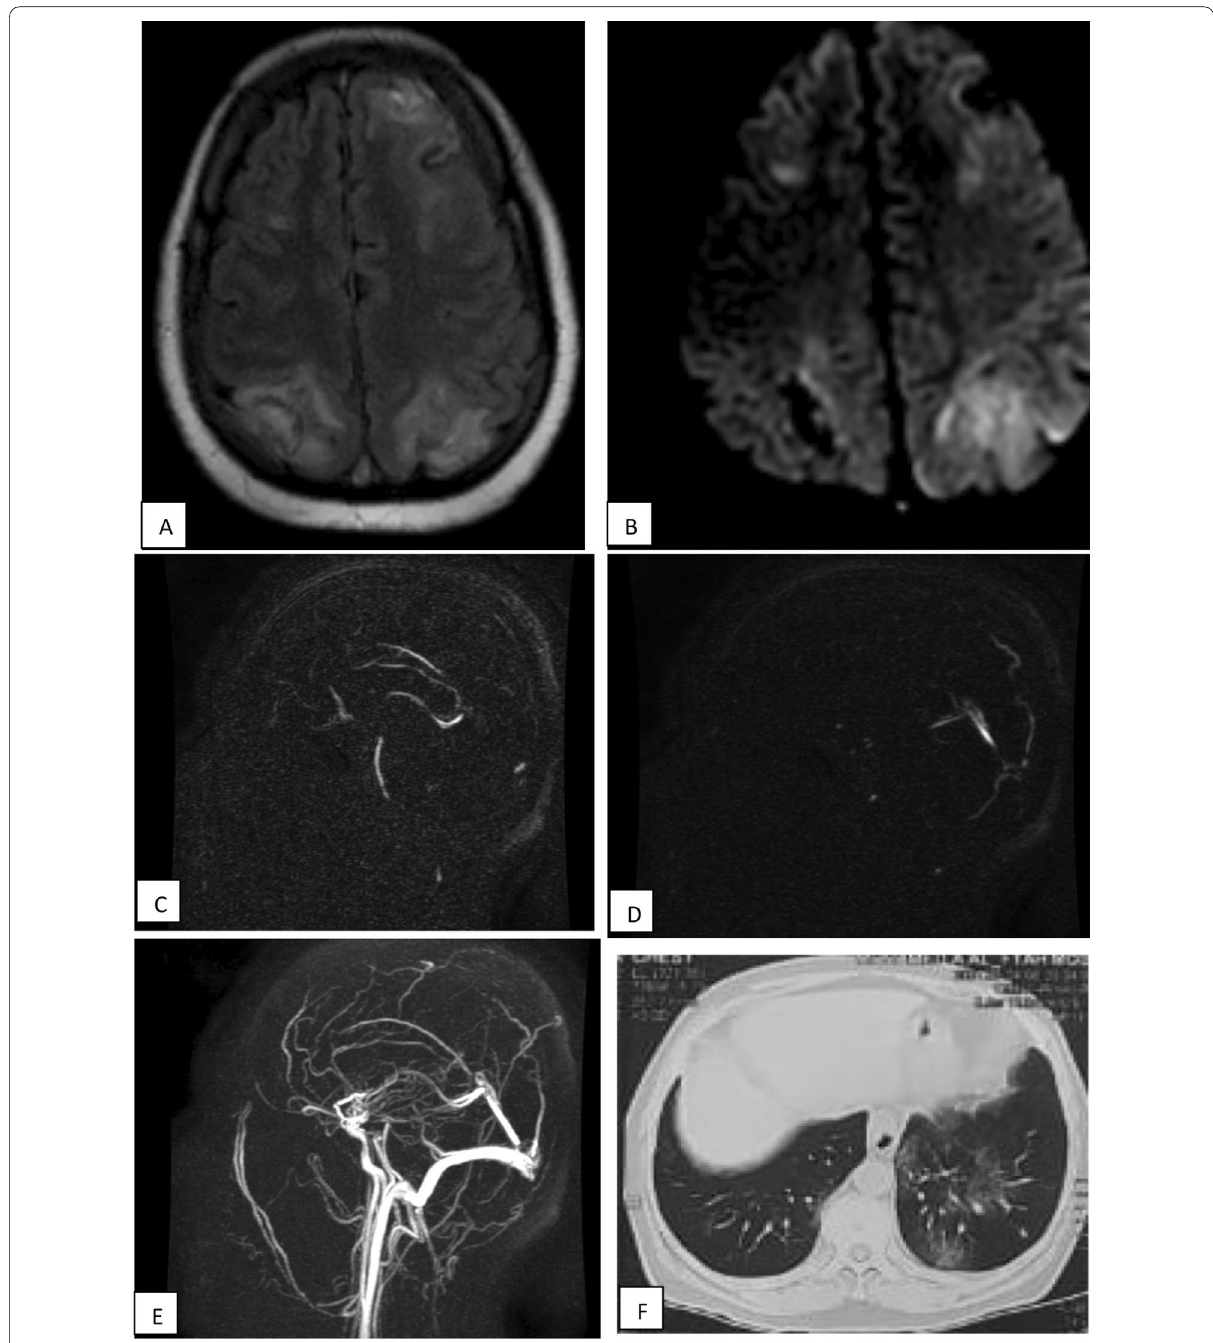
Fig. 1 A 36-year-old male patient, presented with post-COVID headache, seizers and disturbed consciousness. a MRI axial T2WI revealed cortical and subcortical regions of high T2-signal intensities represents non haemorrhagic venous infarctions. b Corresponding regions of restricted diffusion in DWI with b-value1000. c , d and e MRV show near complete obstruction of the superior sagittal sinus. Non haemorrhagic venous infarction is confirmed. f CT chest showed peripheral distributed ground glass opacities typical for COVID-19